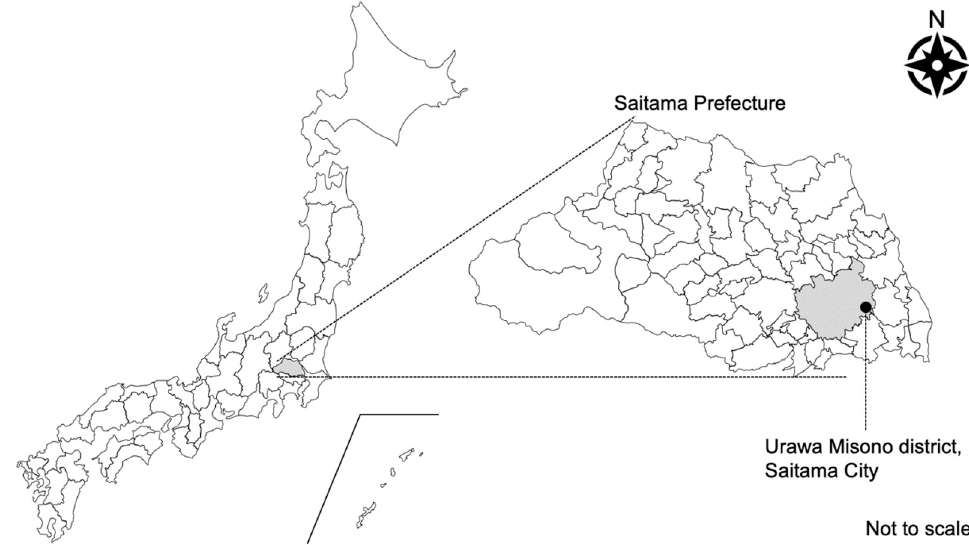
Figure 1. Location of the demonstration project in Urawa-Misono District.